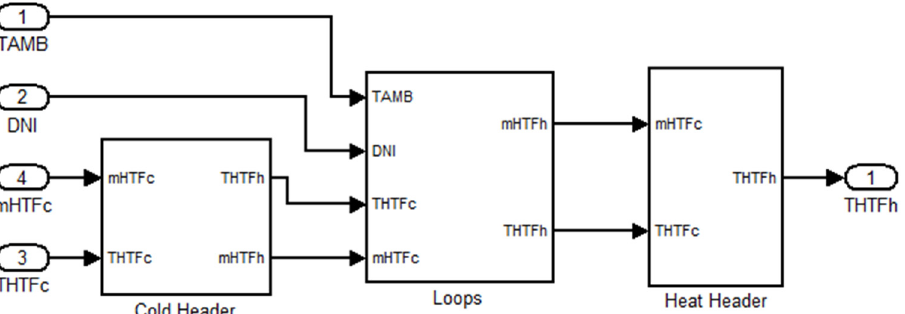
Figure 9. Solar field (SF) model.